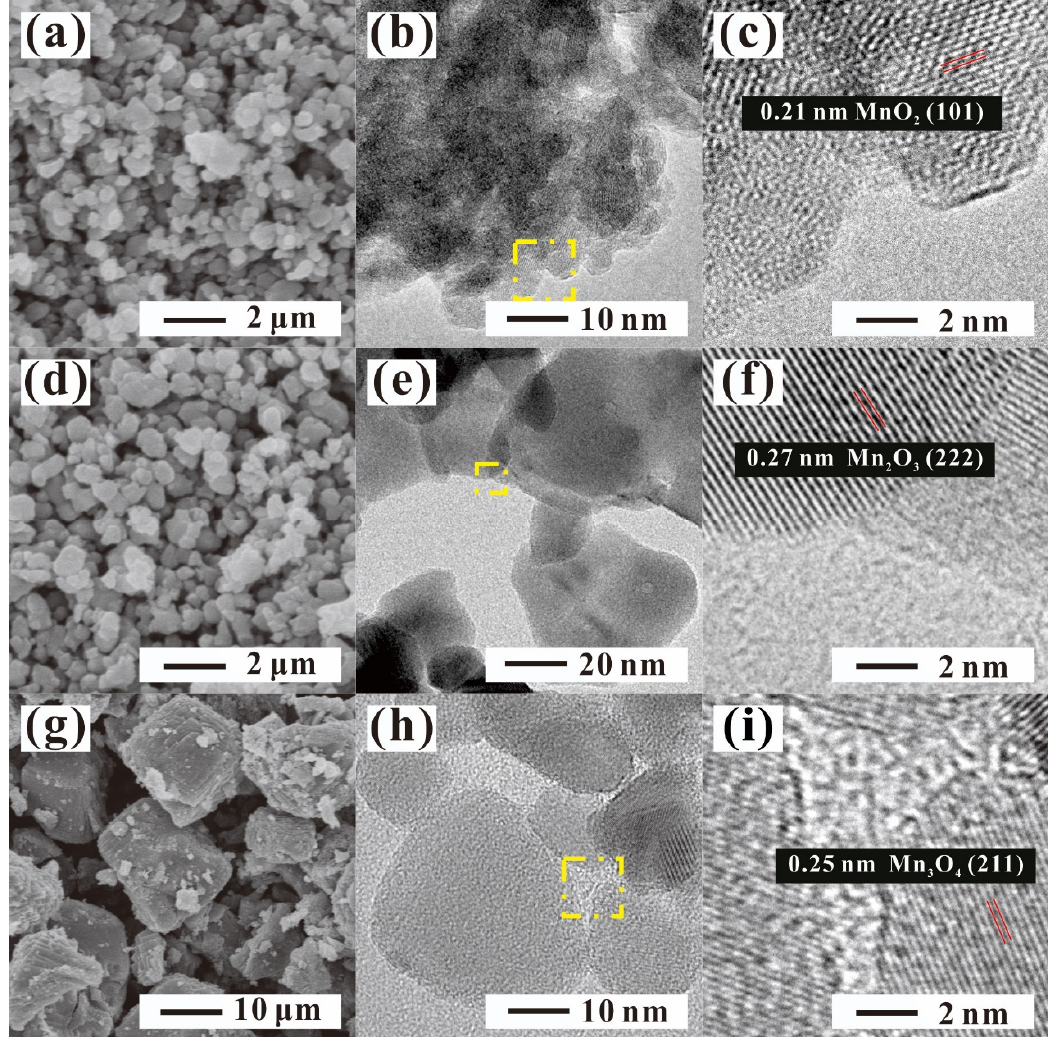
Figure 3. Representative SEM, TEM micrographs of the ( a – c ) MnCO 3 –425, ( d – f ) MnC 2 O 4 -500 and ( g – i ) Mn(OH) 2 -425 catalysts. The high resolution TEM micrograph shows the yellow dotted area in the corresponding TEM micrograph of the catalyst.